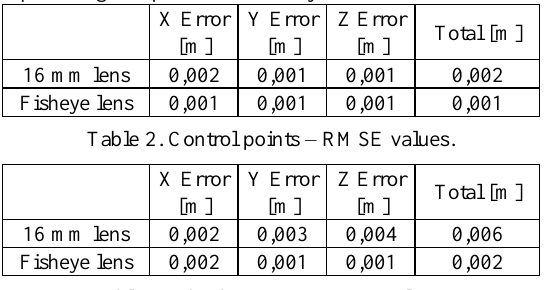
Table 3. Check points – RMSE values.